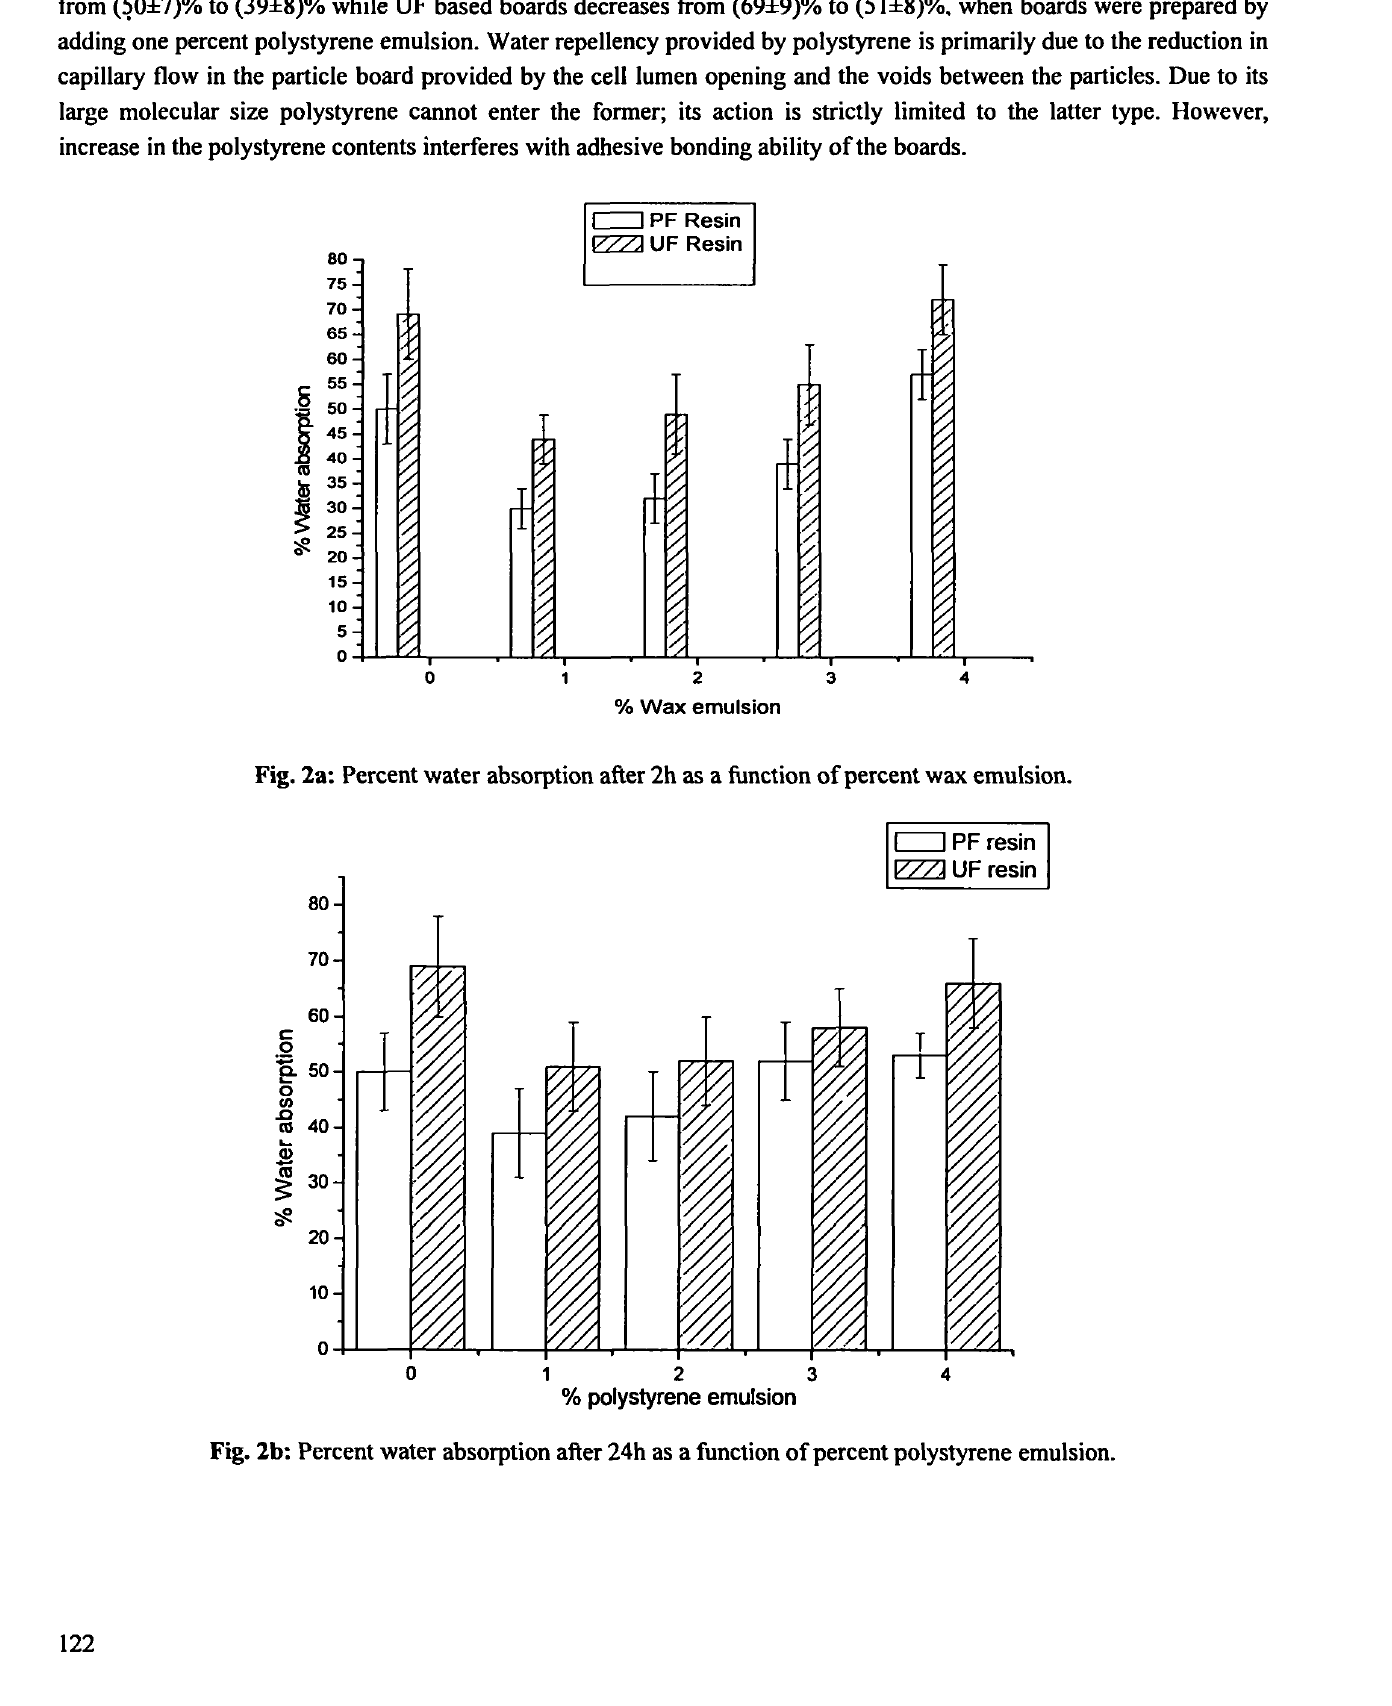
Fig. 2b: Percent water absorption after 24h as a function of percent polystyrene